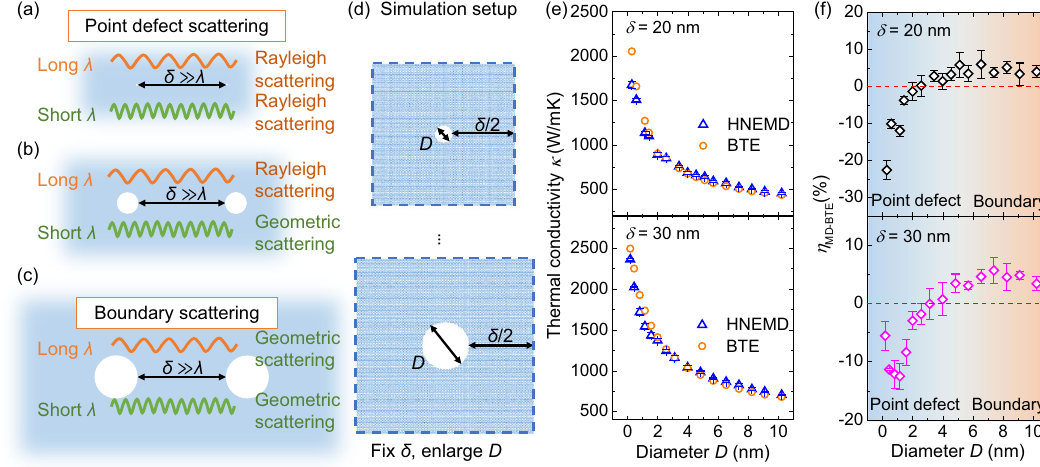
Fig. 3 The crossover from point defect scattering to boundary scattering. a The schematic of point defect scattering. When the entire phonon wavelength λ is larger than the pore size, the pore can be regarded as a point defect, and the phonon scattering follows Rayleigh scattering. b The schematic of phonon scattering between point defect scattering and boundary scattering. When the pore size is comparable to some phonon wavelengths, phonons with longer wavelengths than the pore size would experience Rayleigh scattering, whereas phonons with shorter wavelengths are scattered geometrically. c The schematic of boundary scattering. When the entire phonon wavelength λ is much shorter than the pore size, phonon scattering with pores follows geometric scattering, which can be described as phonon-boundary scattering. d The simulation setup for studying the crossover from point defect scattering to boundary scattering. There is one pore located at the center of the simulation domain with increasing pore size. The interpore distance is fi xed. Periodic boundary conditions are applied to the boundaries of the domain. e Thermal conductivities of porous graphene with different pore sizes at the interpore distance of 20 nm and 30 nm were obtained by HNEMD and phonon BTE. f The relative difference between HNEMD and BTE computed thermal conductivities for different pore sizes. The light blue and light orange regions denote the thermal transport regime dominated by phonon-defect scattering and boundary scattering, respectively. The error bar denotes the standard